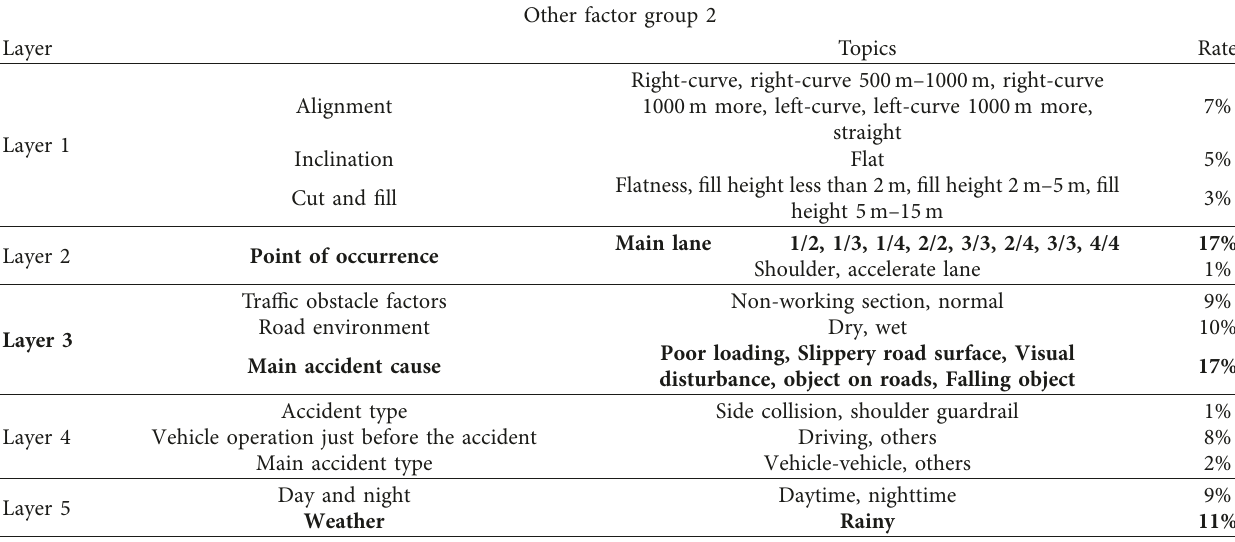
Table 10: Other factor topic modeling group